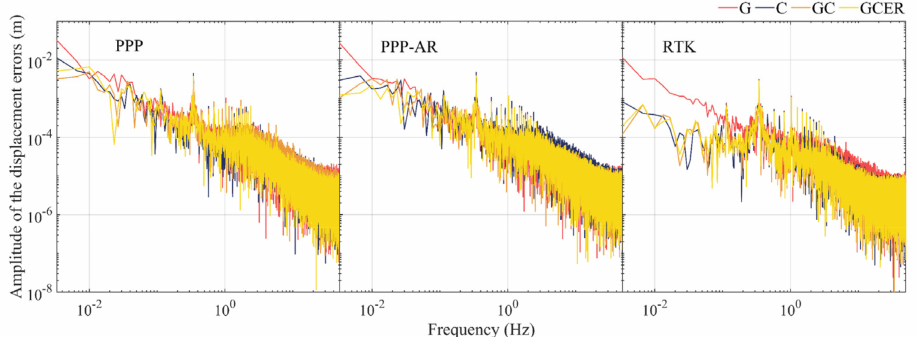
Figure 10. Amplitude–frequency spectra of displacement errors from sinusoidal motion test com- puted with observations from the different satellite systems G, C, GC, and GCER, respectively. From left to right, results from PPP, PPP-AR, and